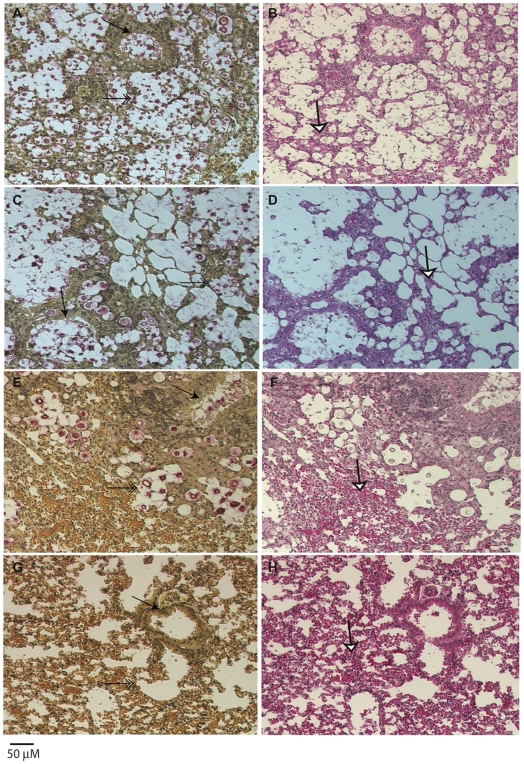
Histopathology of lungs of mice infected with C. gattii.Male, BALB/c mice were infected with 1×105 yeast cells via intranasal instillation. The infected lungs were harvested at two weeks post-infection and processed as described above. Note that airway (arrow, A) and all the alveoli (double arrow, A) were packed with rapidly dividing yeasts with minimum tissue response (white arrow, B) in mice infected with highly virulent strain CA1499, while moderately virulent strain CA1292 showed a similar pattern except that several empty alveoli surrounding infected alveoli were observed (C, D). In contrast, the low virulene strain WM161 revealed less multiplication of C. gattii with a majority of alveoli containing one or two yeasts with an influx of inflammatory response (E, F). No yeast was seen in the lungs of mice infected with avirulent strain CA2339 and a vigorous inflammatory response was visible throughout the lung section (G, H). (Mucicarmine and H & E staining, ×100 magnification, scale bar 50 uM).